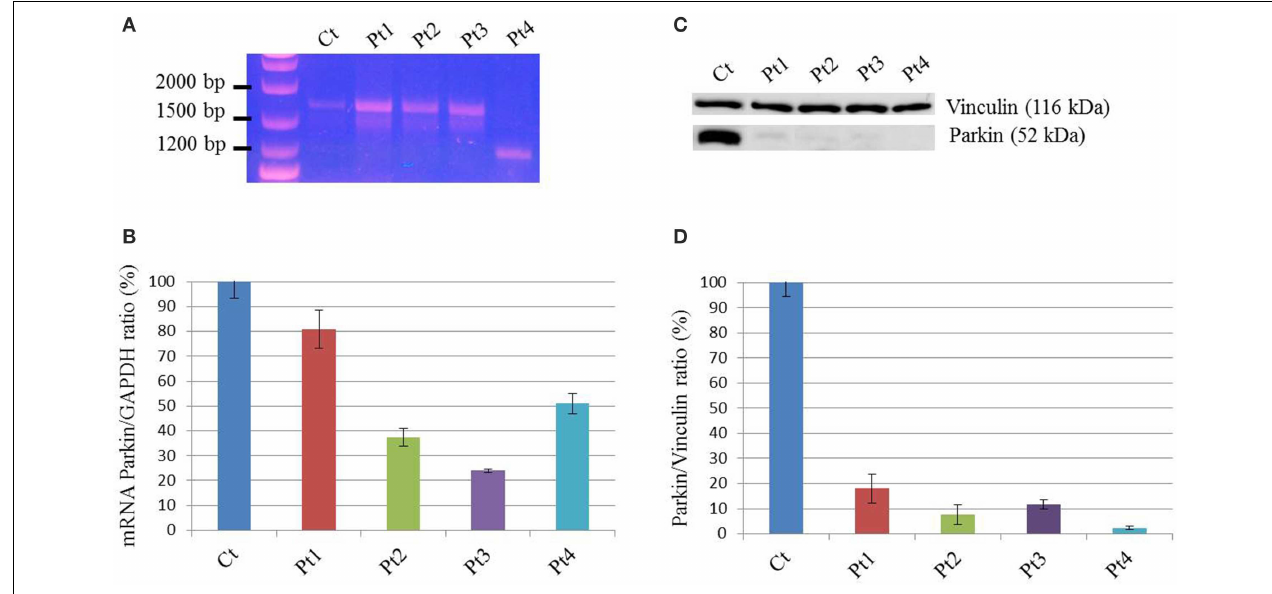
FIGURE 1 | mRNA and protein levels of Parkin. (A) PCR amplification on cDNA obtained from mRNA extracted from patients (Pt) and control (Ct) fibroblasts, using primers in the 5 ′ and 3 ′ -UTRs PARK2 regions. The band corresponding to full-length transcript was present in Ct, Pt1,